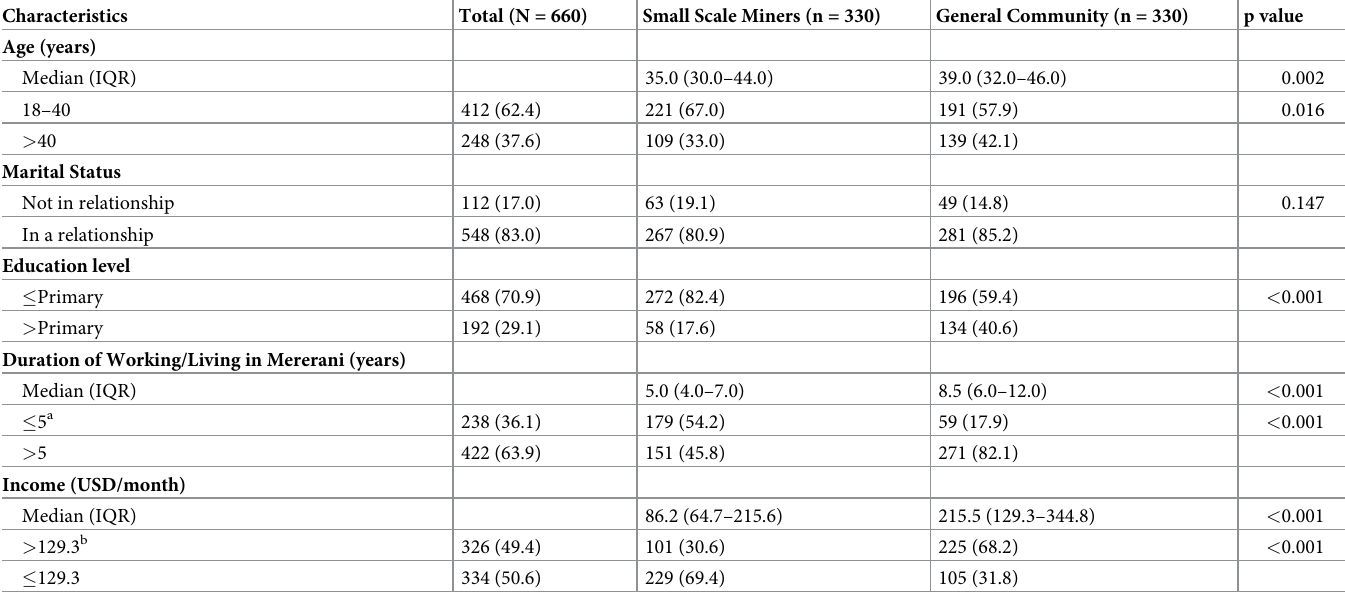
Table 1. Socio-demographic characteristics of the mining communities in Mererani (N =